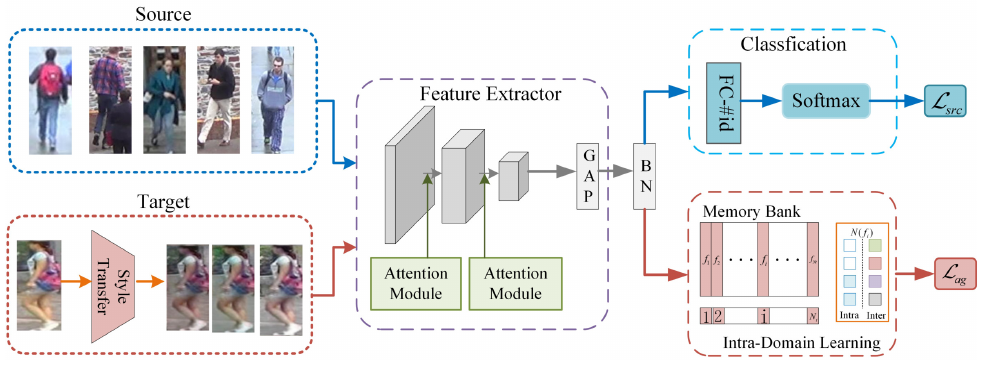
Figure 1. The framework of the proposed method. For UDA person re-ID, a labeled source dataset S = { X s , Y s } that contains N s pedes- trian images is obtained. The source domain contains N s images of P pedestrians. Each image corresponds to an identity label y s . There are N t unlabeled target images { x t i from the unlabeled target dataset T = { X t } . The identity of each target image x t in { X t } is unknown. In addition, the camera index of an image (for example, C s = { c s } N t C t = { c t ) is available in both domains. Given the above information, learning a model i i = 1 that can be well generalized to the target domain is